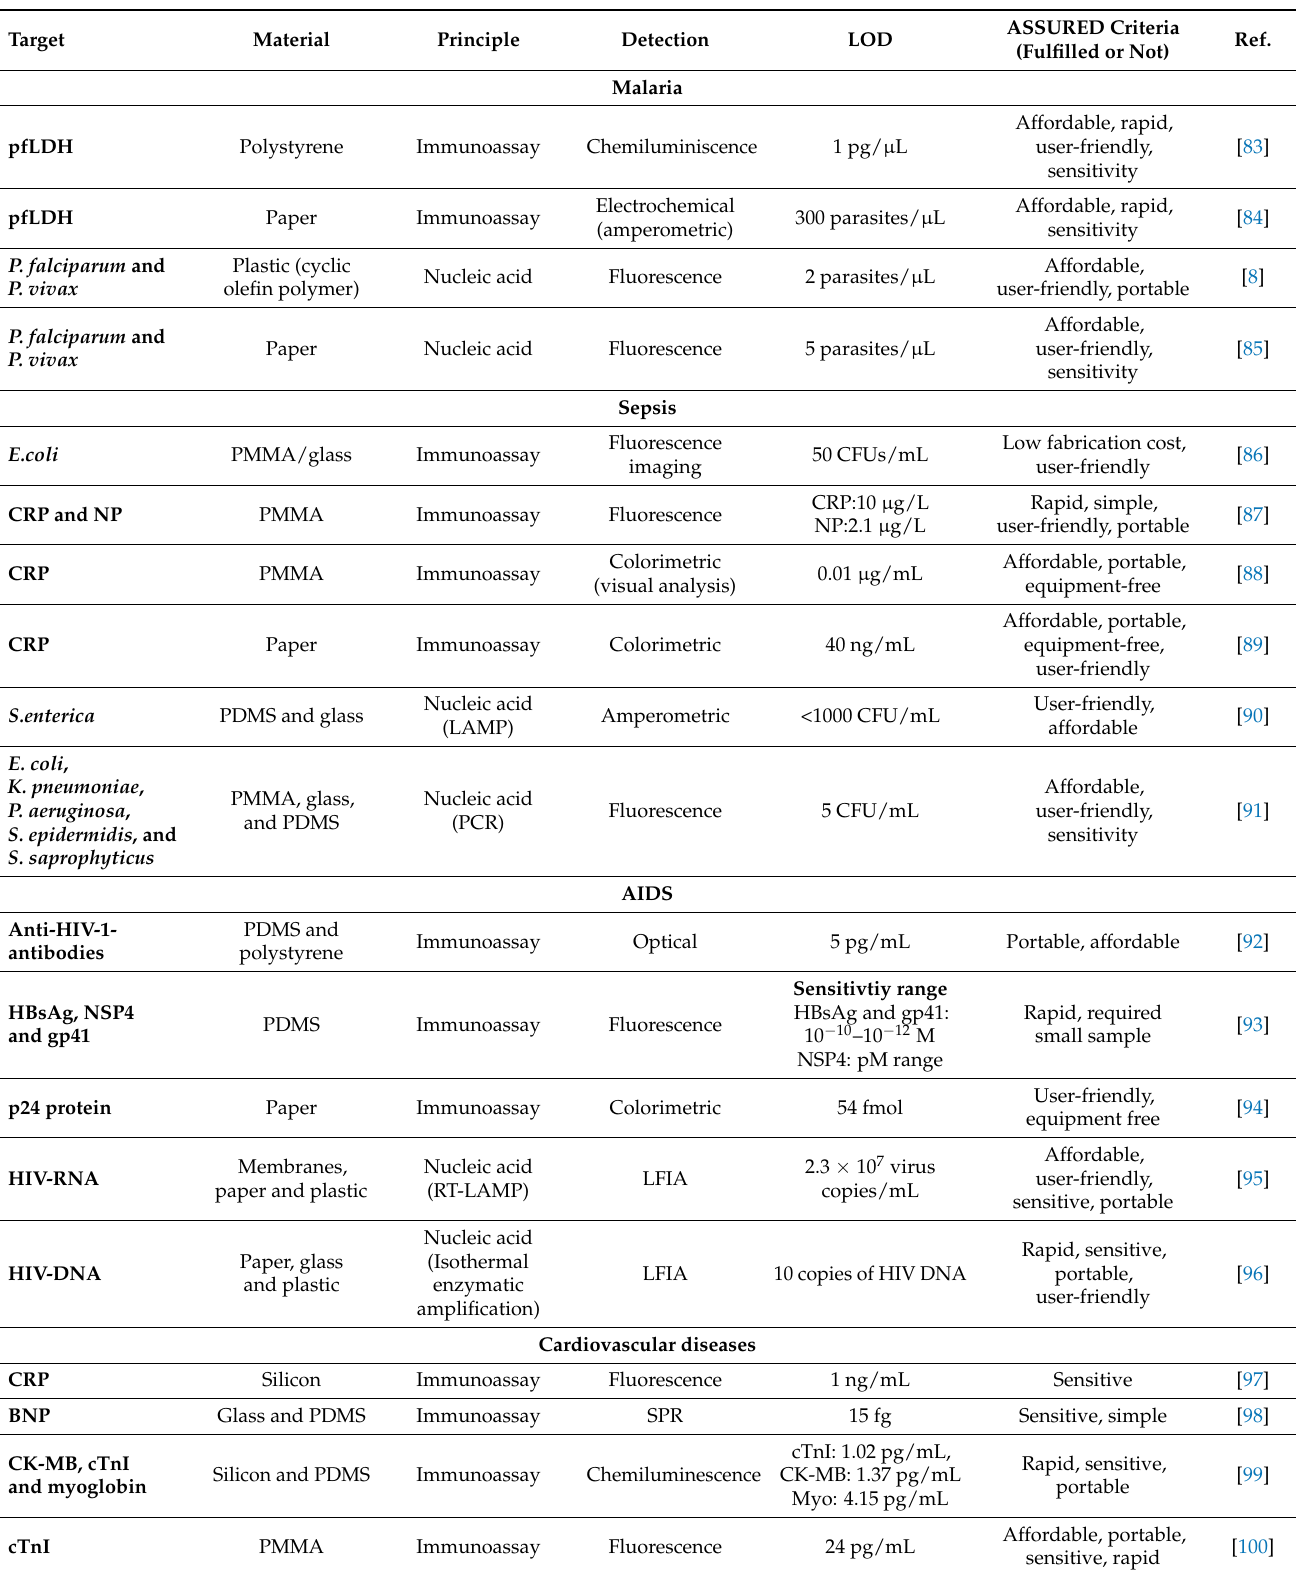
Table 1. Summary of the microfluidic chip biosensors for the detection of malaria, sepsis, AIDS, and cardiovascular